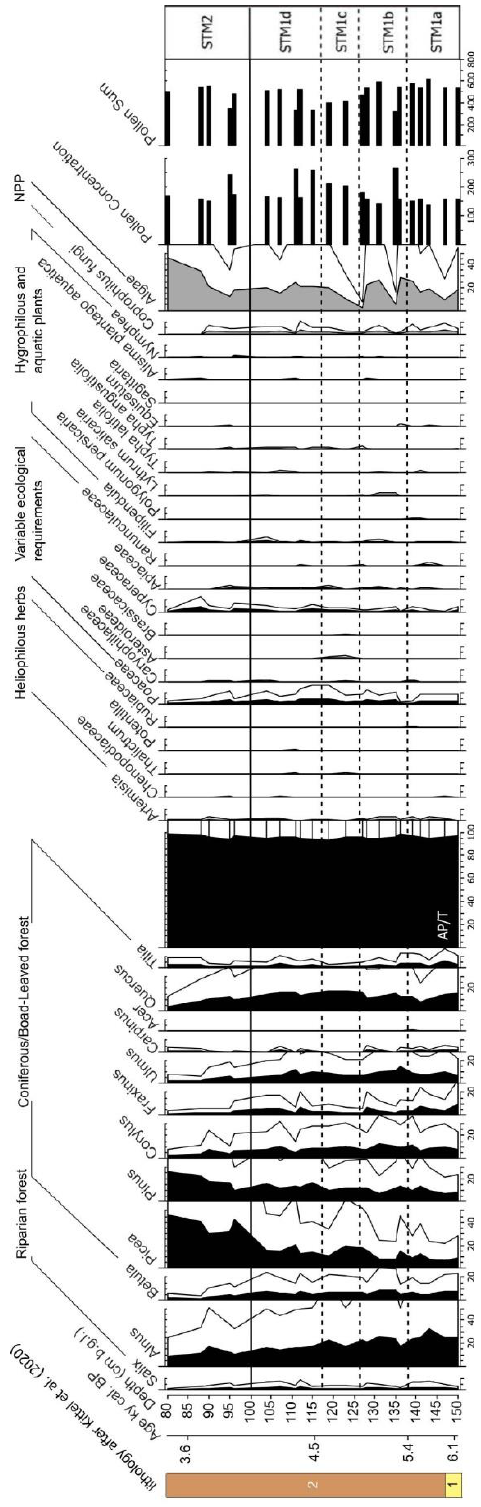
Figure 4. Pollen stratigraphic diagram. Exaggeration is with a three times multiplier. Lithology: 1—sand and gravel with organic mud and plant detritus; 2—coarse detritus gyttja.